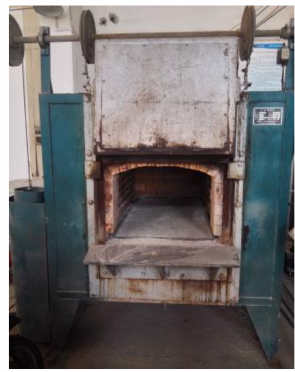
Figure 2. High-temperature installation.